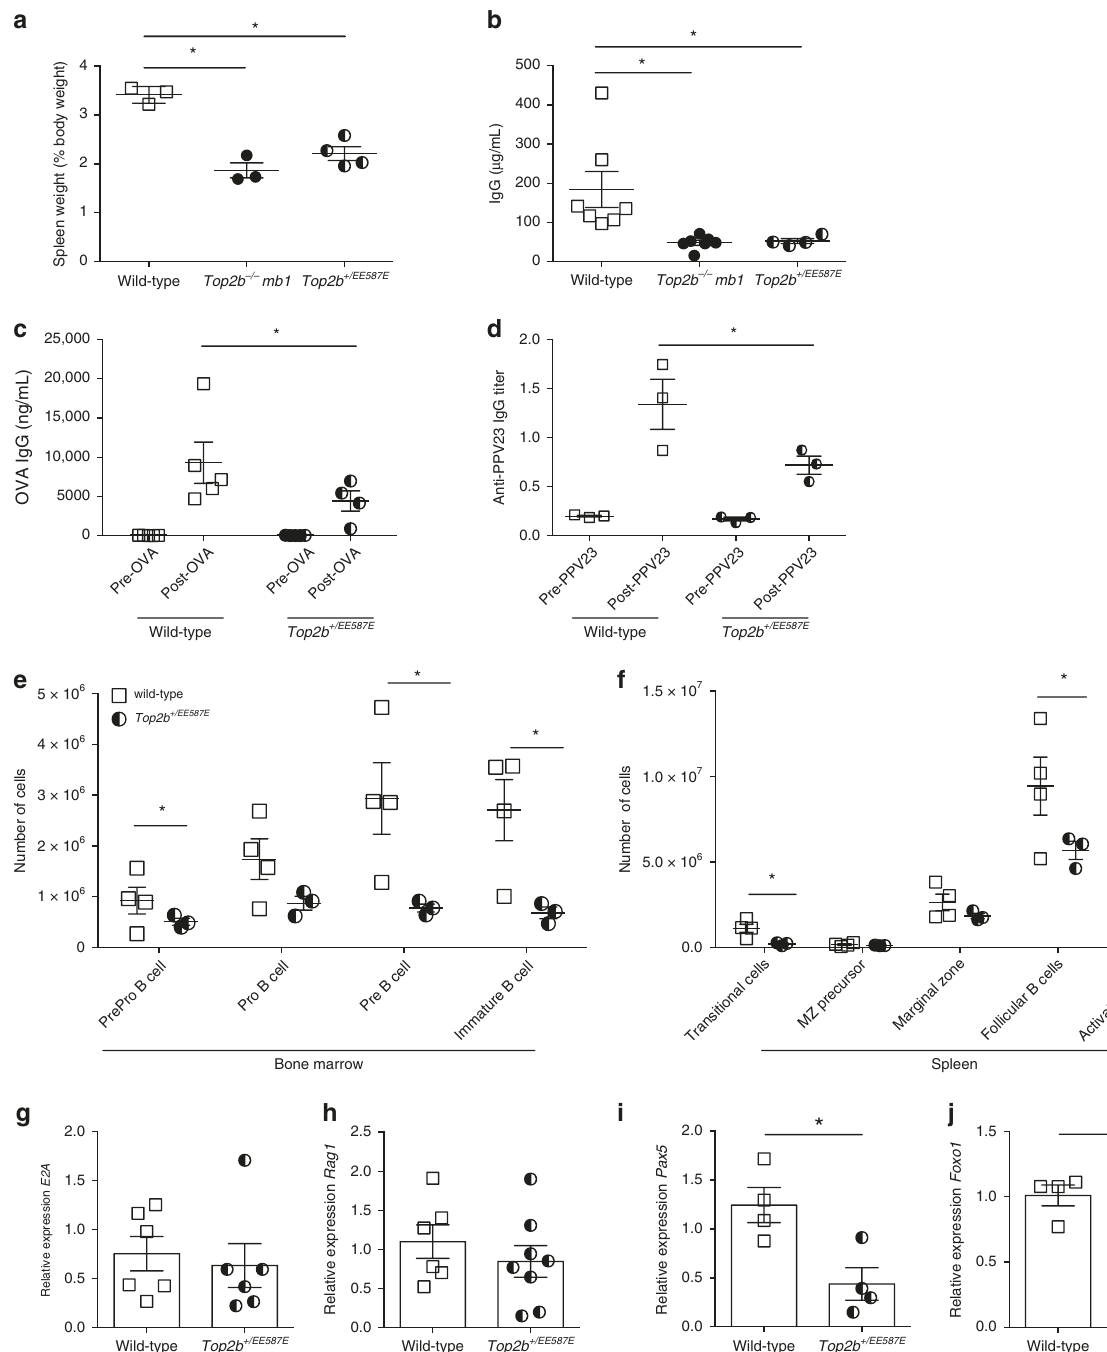
Fig. 5 B cell development is negatively affected when TOP2B is mutated. a Spleen to body weight ratio for wild-type ( n = 3), Top2b − / − -mb1 cre ( n = 3), and Top2b + /EE587E mice ( n = 4) reveal smaller ratios in knockin and knockout mice compared to controls (shown as mean ± SEM). * p < 0.05 by Kruskal – Wallis test. b Total serum IgG is reduced in Top2b − / − mb1 cre mice ( n = 6) and Top2b + /EE587E ( n = 4) mice compared to controls ( n = 7, shown as mean ± SEM). * p < 0.05 by Kruskal – Wallis test. c , d Heterozygous mutant mice fail to produce speci fi c IgG antibody in response to vaccination with ovalbumin (OVA, n = 4, ( c ) or pneumovax-23 ( d ) ( n = 3 mice per group, shown as mean ± SEM, * p < 0.05 by the Kruskal – Wallis test). Bone marrow ( e ) and spleen ( f ) cells were isolated from Top2b + / EE587E mice and littermate controls. Phenotypic analysis by fl ow cytometry demonstrates that the bone marrow of Top2b + /EE587E mice ( n = 3) have fewer PrePro B cells (Fr. A, B220 + , CD43 − , BP1 − , CD24 − ), Pre B cells (Fr. D, B220 + , CD43 − , IgD − , IgM − ),